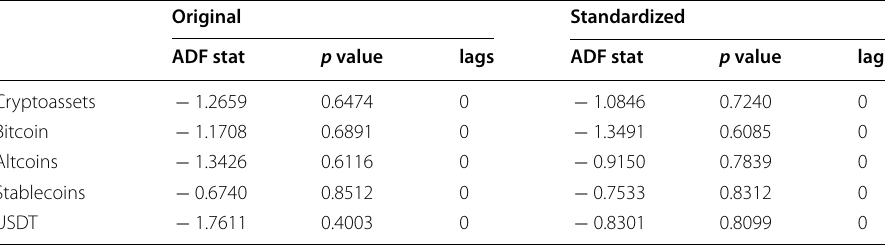
The augmented (Dickey and Fuller 1979) test is performed on the original (logarithmic) series (left panel) and the standardized ones (integrated demeaned and standardized logarithmic differences of the original series, right panel). The optimal number of lags for the test is based on BIC (also shown in the